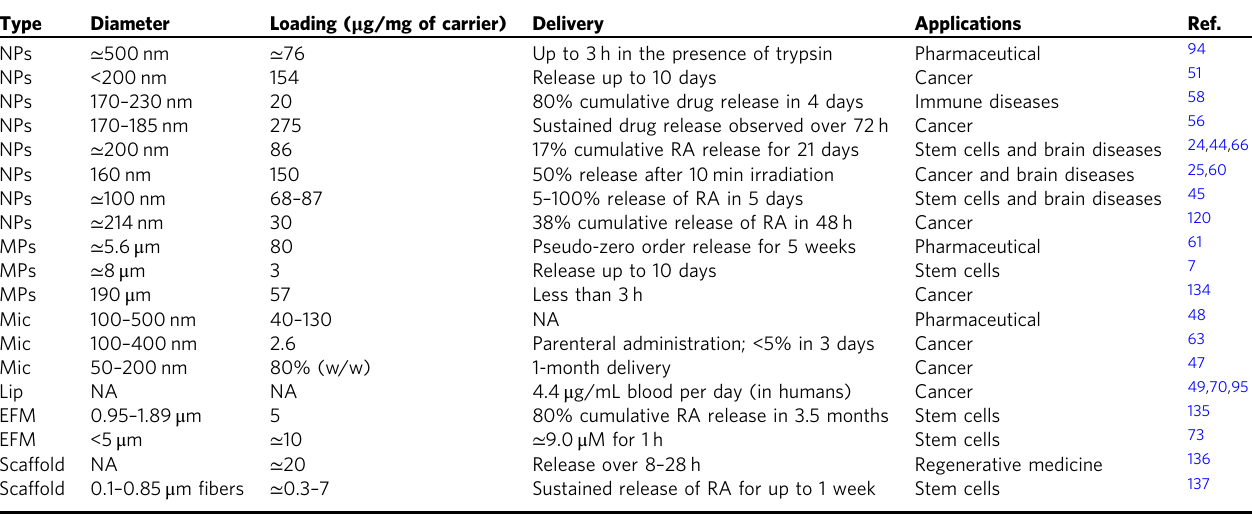
Table 3 Examples of formulations for the controlled release of RA in the context of cancer, brain diseases, skin diseases, immune diseases, stem cell differentiation, among other